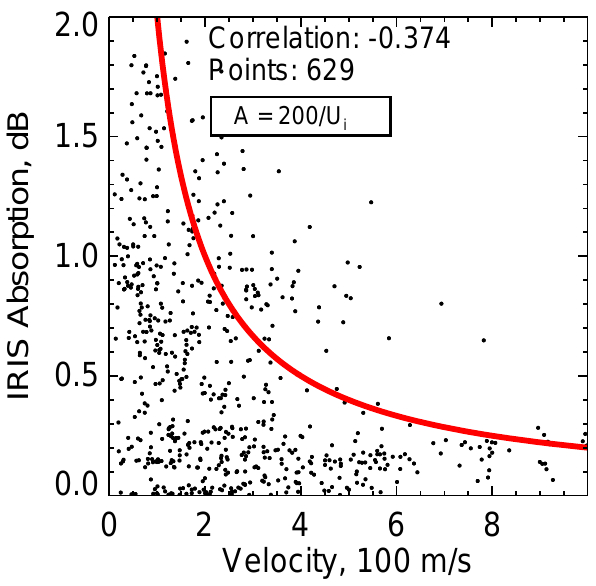
Fig. 9. Scatter plot of absorption versus velocity for the 12:00– 15:00MLT time sector for 9 days exhibiting high correlation inter- vals within this period (see text for details). The format is the same as for each panel in Fig. 5. The red curve represents an inverse proportionality trend described by the equation shown on the